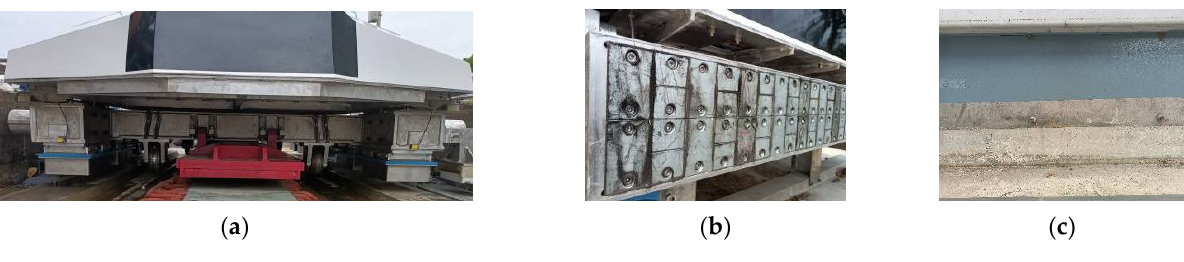
Figure 1. An HTS maglev test vehicle equipped with PMECBs: ( a ) the test vehicle; ( b ) the PMECB composed of Halbach permanent magnet array fixed on both sides of the vehicle; ( c ) the metal in- duction plates.